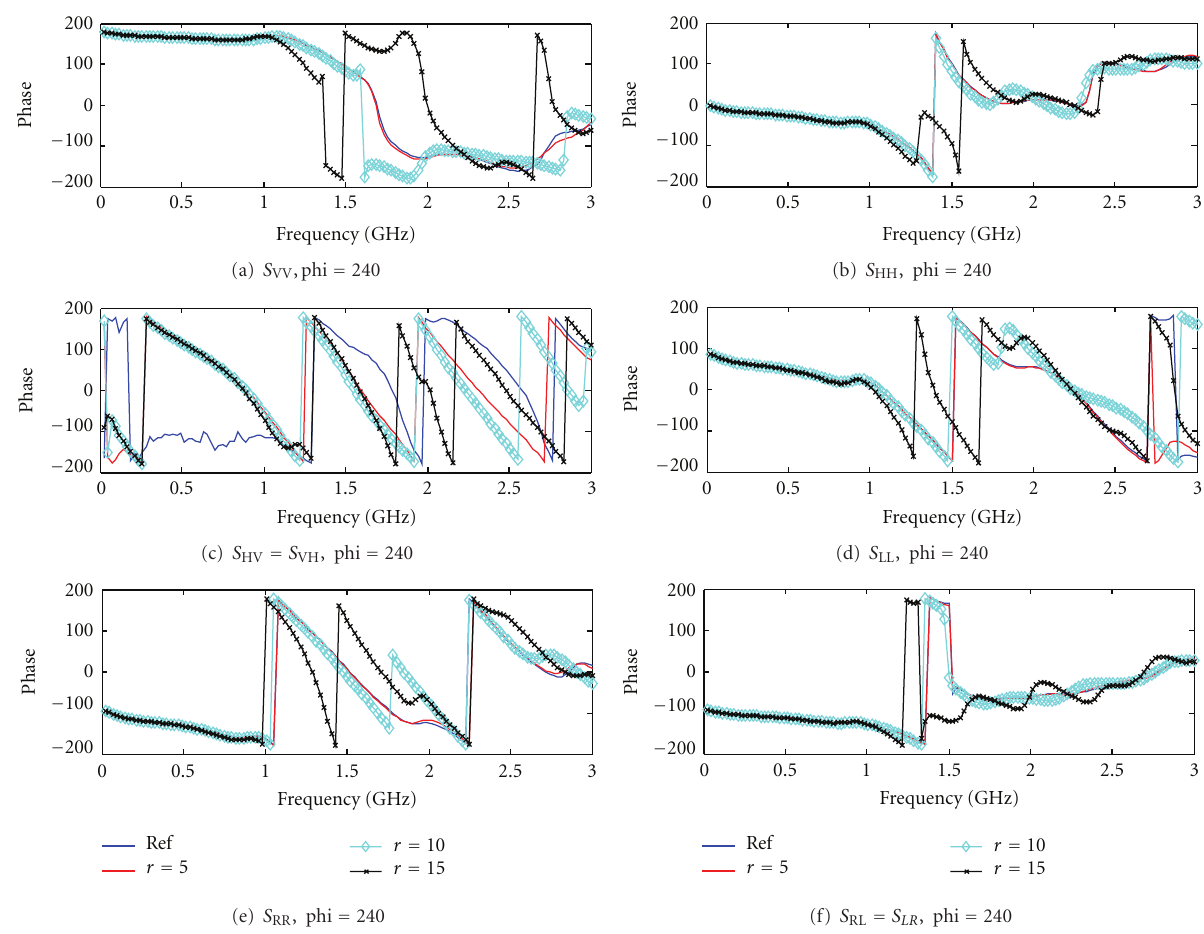
Figure 5: Phase amplitude response from breast volumes in frequency domain at θ = 105 ◦ , ϕ t = ϕ r = 240 ◦ . (a) S VV , (b) S HH , (c) S HV = S VH (d) S LL , (e) S RR , and (f) S RL = S LR .